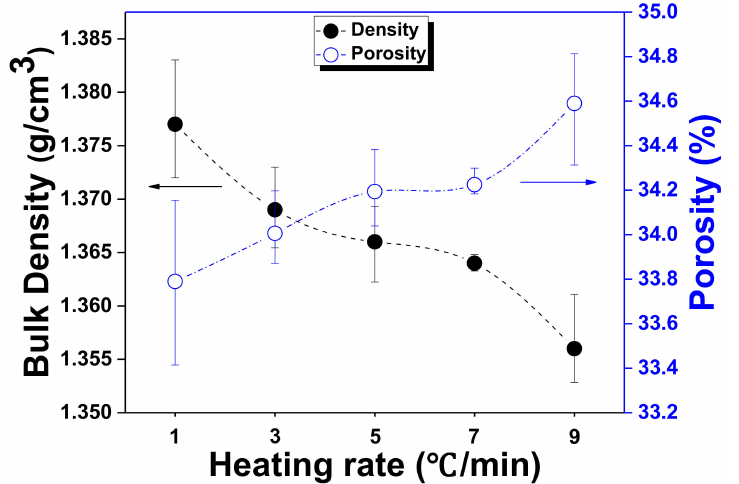
Figure 3. Bulk density and porosity of graphite blocks as a function of heating rate.